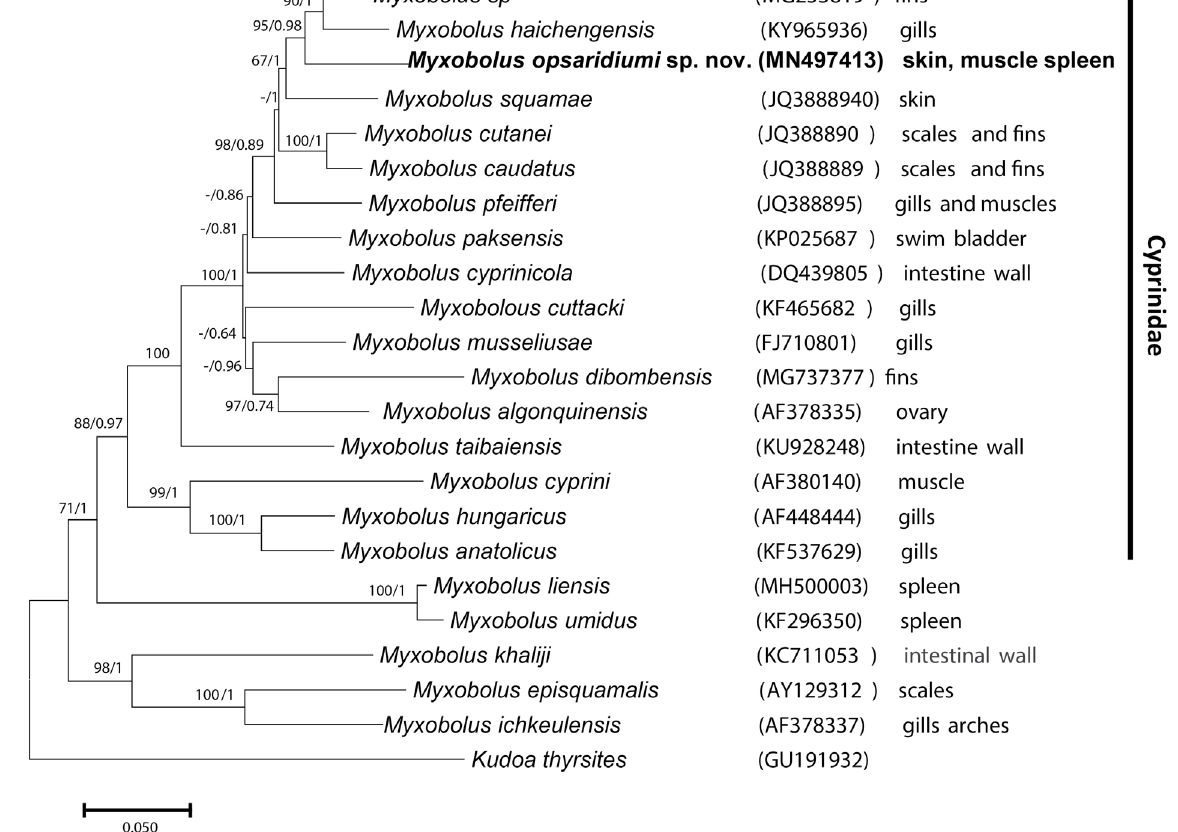
Fig. 4. Maximum likelihood phylogenetic tree based on the SSU rDNA sequences showing the position of Myxobolus opsaridiumi sp. nov. (in bold) and related species. Accession numbers and infected tissues are listed adjacent to the species names. Numbers at the nodes represent Bayesian posterior probabilities and ML bootstrap percentages. Kudoa thyrsites (Gilchrist, 1924) was used as the